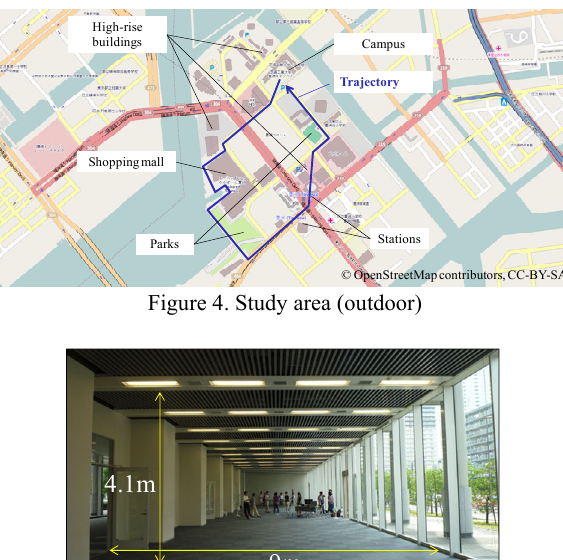
Figure 2. Position data acquisition in an indoor environment